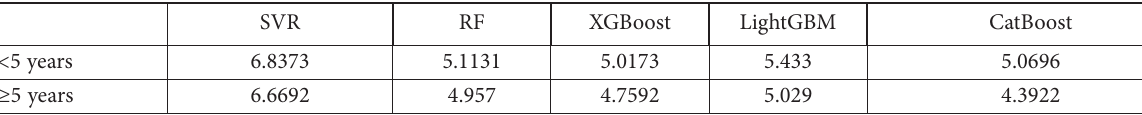
Table 6. MAPE values calculated according to the number of years